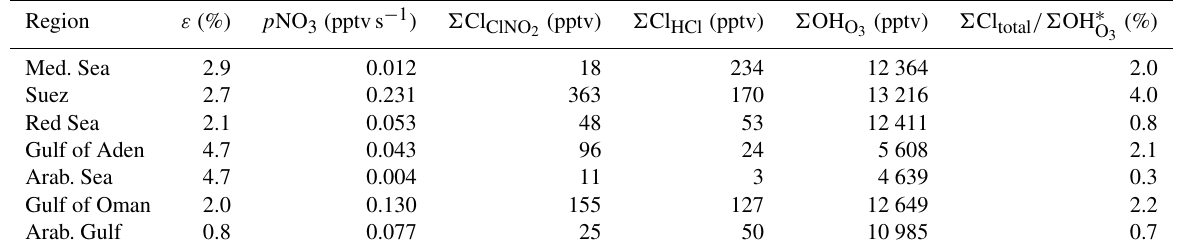
Table 3. Regional variability in ε , p NO 3 , and OH and Cl radical production integrated over one diel cycle.